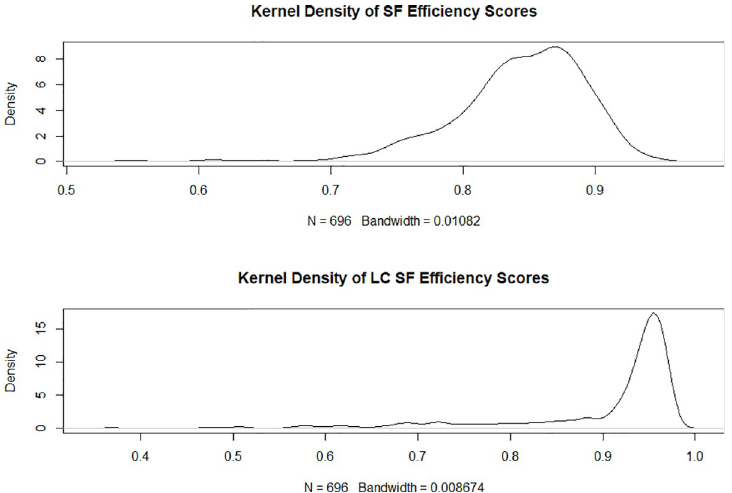
Fig 2. Kernel density estimate for the stochastic frontier and latent class efficiency scores for the complete sample (stochastic frontier efficiency scores above). Source: own illustration.